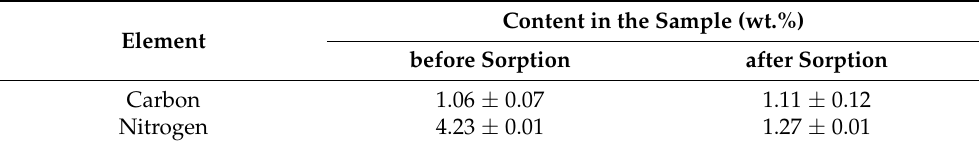
Table 7. Carbon, and nitrogen contents (in percent by mass) of the hexadecylamine-vanadium oxide material after one exchange with NH 4+ , as corresponding to the plateau sorption value in Figure 8. Content in the Sample (wt.%) Element before Sorption after Sorption Carbon